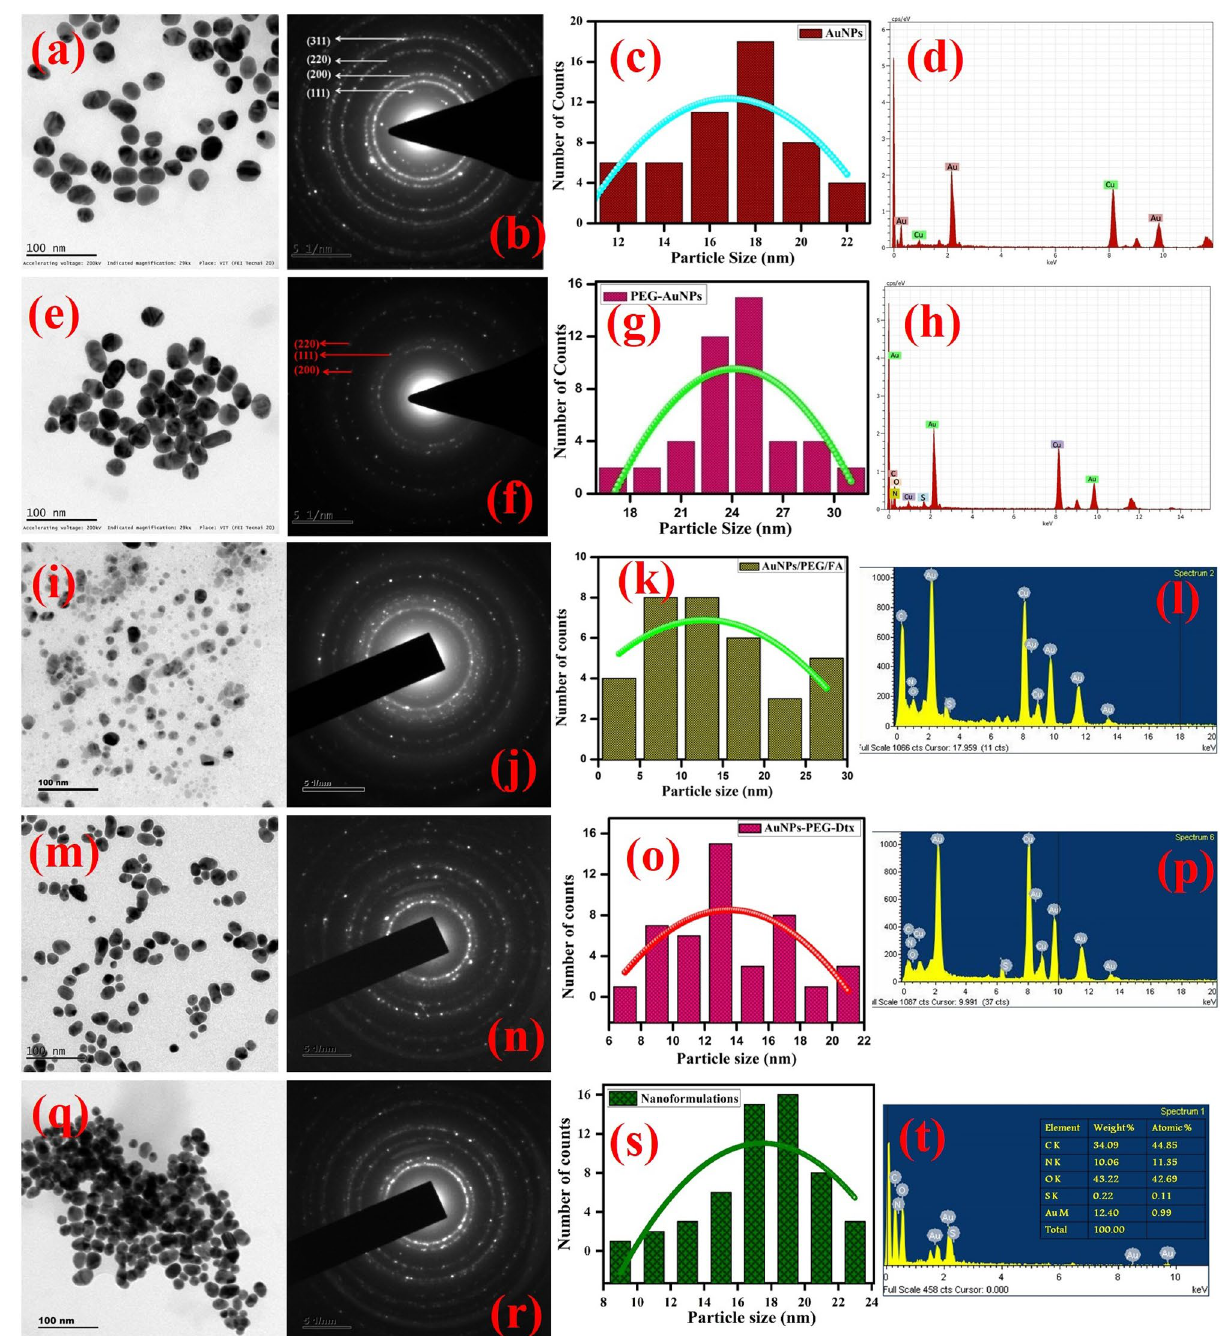
Figure 5. HR-TEM images of the gold nanoformulations ( a – d ) AuNPs TEM image, SAED, particle size distribution and EDS spectrum followed by the similar characteristics were carried for remaining particle, ( e – h ) PEG functionalized AuNPs, ( i – l ) FA conjugated AuNPs-PEG, ( m – p ) Dtx loaded AuNPs-PEG and ( q – t ) drug encapsulated gold Dtx, AuNPs-PEG-Dtx, and AuNPs-PEG-FA-Dtx, which observed the strongest band of gold, sulfur, carbon, nitrogen, and oxygen (Au4 f , S2 p , C1 s , N1 s , and O1 s ), respectively. Figure 7b depicts the survey spectrum of the AuNPs. The valence band and binding energy of 4 f core level spectrum of AuNPs have observed the peaks at 85.3 eV and 88.9 eV corresponds to the Au 4 f 7/2 and Au 4 f 5/2 spin orbitals, respectively (Fig. 7c) 25 . These bind- ing energies were compared to the respective core levels of bulk Au crystals. Evidently, this result exhibited the metallic types of gold (Au 0 ) were present in the sample. Moreover, the resulted value of Au 4 f 7/2 and Au 4 f 5/2 exhibits the narrow width revealed that only a single element of gold was present in the system which indi- cates the synthesized AuNPs are highly stable. The Au4 f core level spectrum of the SH-PEG-NH 2 functionalized AuNPs exhibited the two components at 85.22 eV and 89.01 eV corresponds to the Au 4 f 7/2 and Au 4 f 5/2 of spin